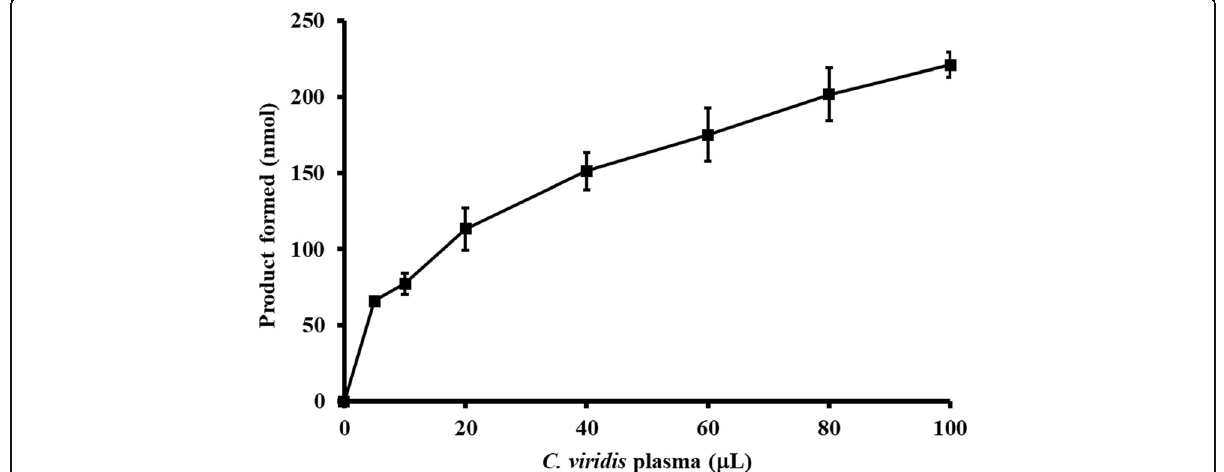
Fig. 1 Volume-dependent lysis of labeled membrane fatty acids from bacteria by plasma derived from Crotalus viridis . The results represent the means ± sd of four independent trials